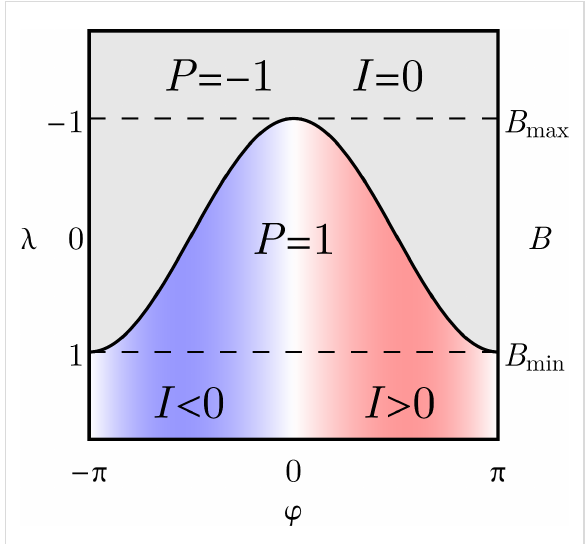
Figure 3: Topological phase space of a 0D topological supercon- ductor realized by a quantum dot coupled with two superconducting leads (SC–QD–SC junction). The system realizes, respectively, a trivial state P = 1 for small Zeeman fields | B | < B min (i.e., λ > 1), and a nontrivial state P = − 1 for large fields | B | > B max (i.e., λ < − 1). The Josephson current vanishes in the nontrivial state. Topological transi- tions coincides with the occurrence of zero-energy modes at ± φ * = ±arccos( −λ ) (solid line) for intermediate fields B min < | B | < B max (i.e., | λ | < 1). In this case the system is in its trivial P = 1 and nontrivial P = − 1 state respectively for within the interval